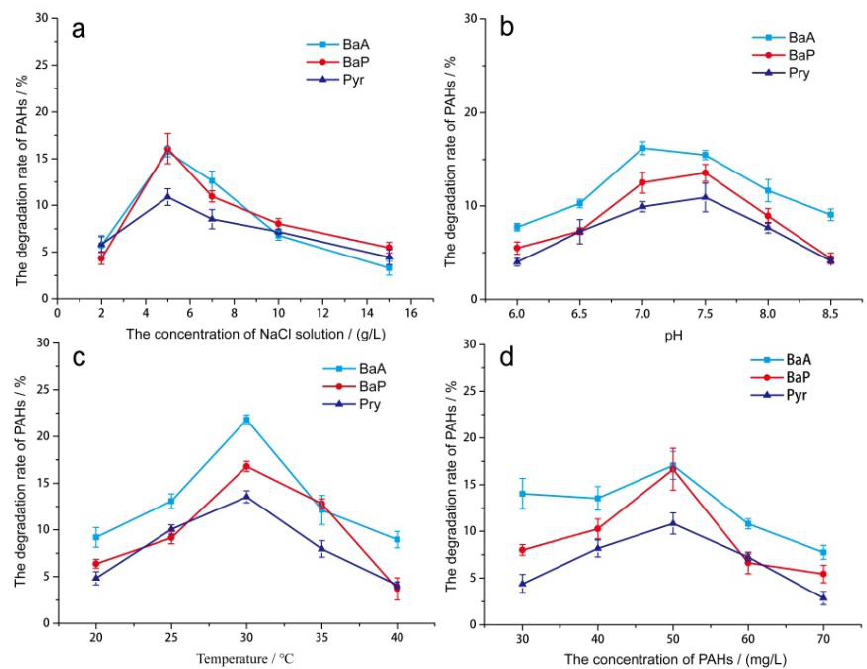
Figure 3. PAH-2 degradation rate of BaA, BaP, and Pyr at different values of: temperature ( a ), pH ( b ), NaCl concentration ( c ), PAH concentration ( d ). In the figure, the red lines represented the degradation, and the blue lines represented the CFU/mL. Each degradation experiment was repeated three times to ensure repeatability and accuracy of the data.